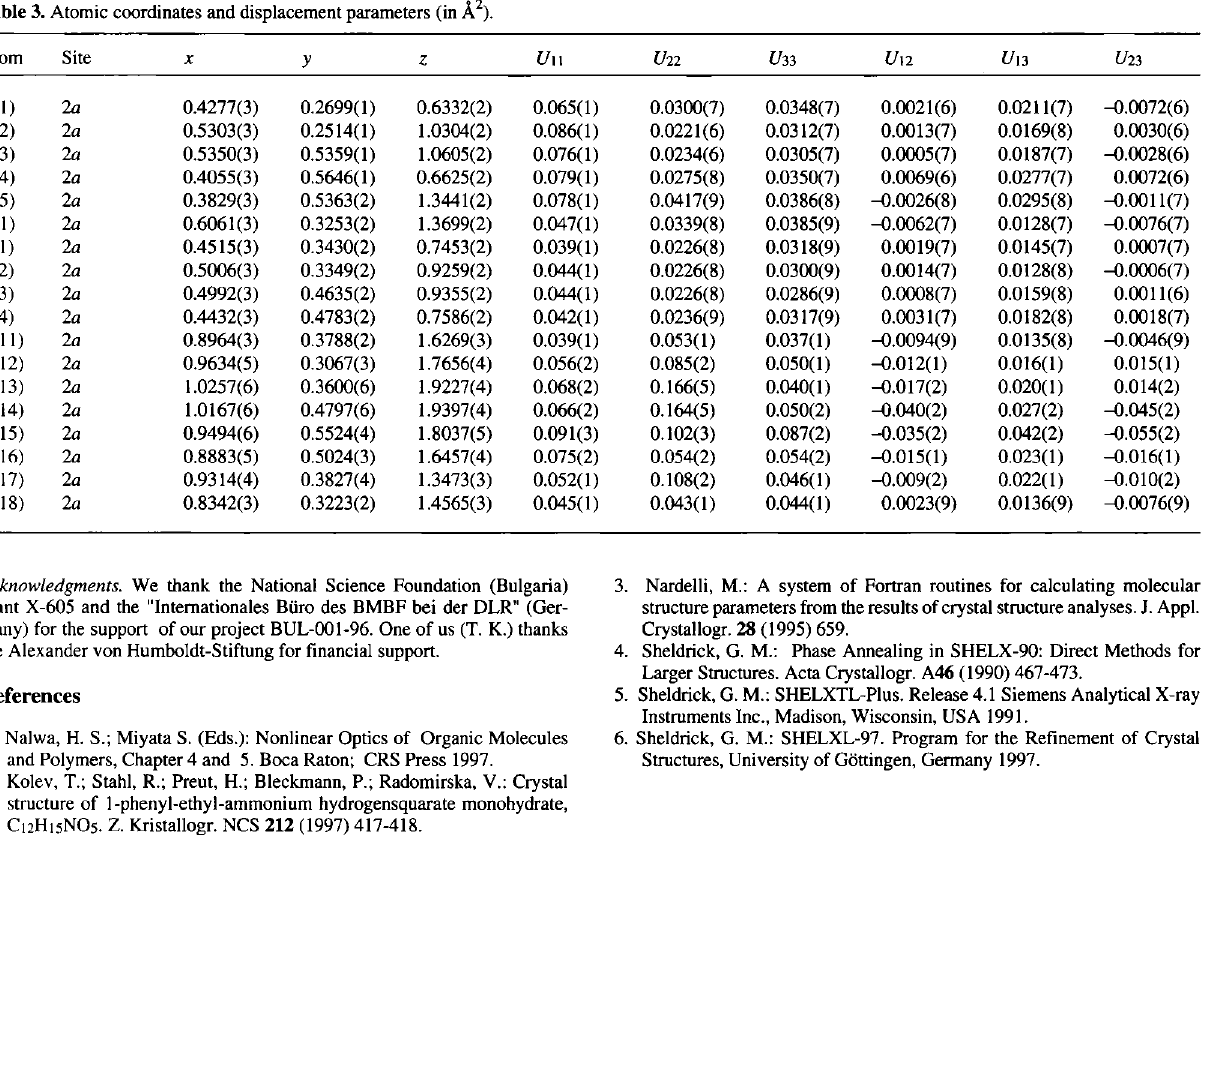
Table 3. Atomic coordinates and displacement parameters (in Ä 2